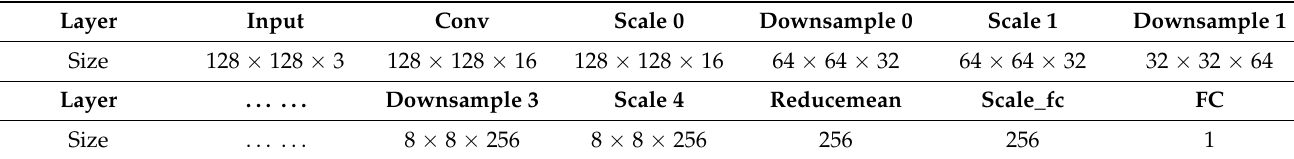
Table 3. Output size of the layer in the discriminator network.